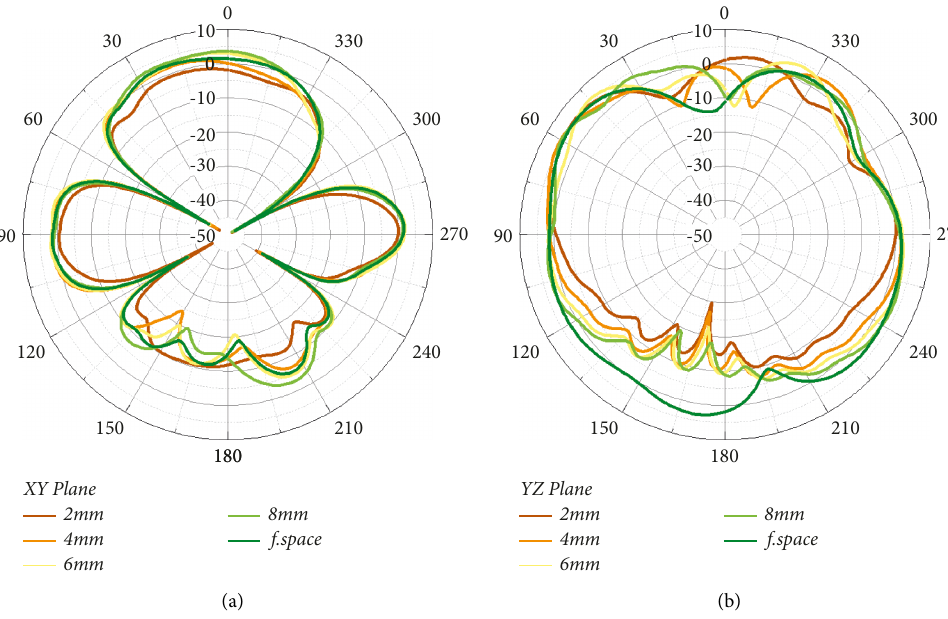
Figure 46: Radiation patterns of the 1 × 4 array antenna for different distances (a) on XY plane and (b) on YZ